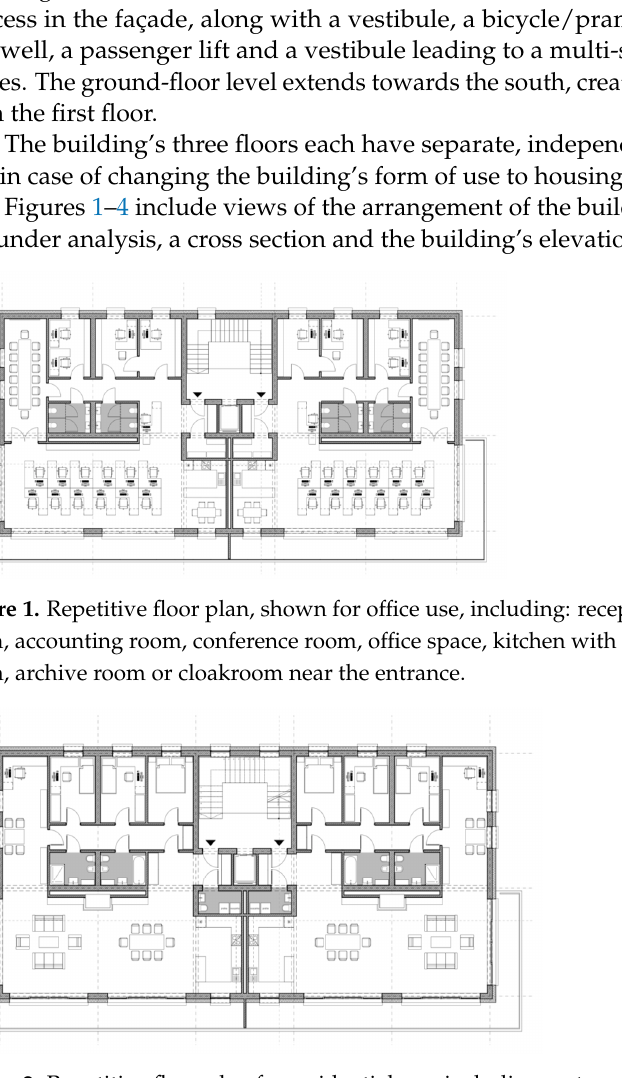
Figure 3. Transverse cross-section of the building with extended ground-floor bays due to the presence of a multi-space car park and distinctive balconies from the south, with a reach that pro- tects south-facing apartments during summer (high incidence angle of solar rays) and enables the insulation of the interior and passive solar gains during winter (low incidence angle of solar rays).